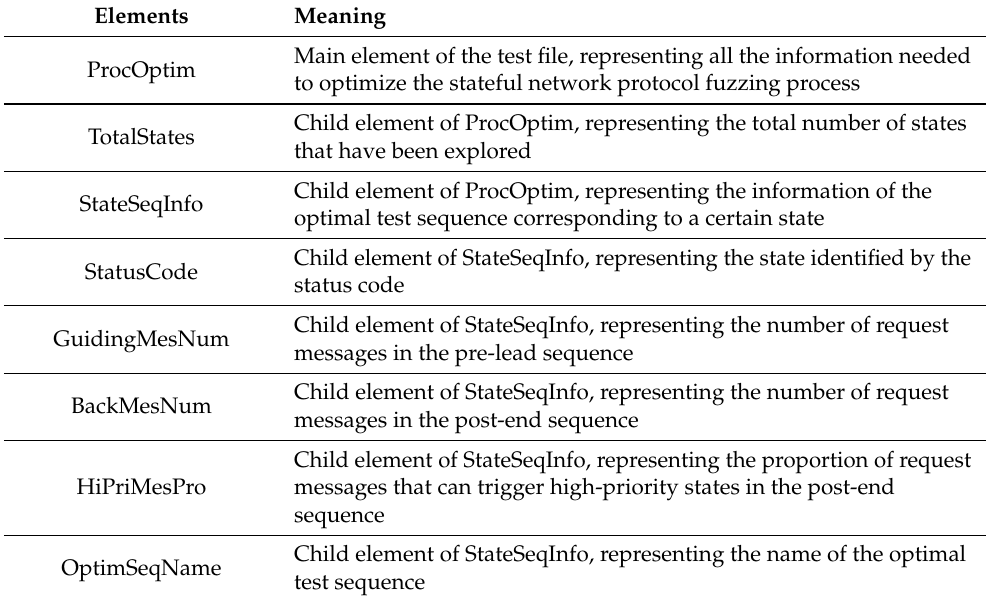
Table 3. Basic elements of the test